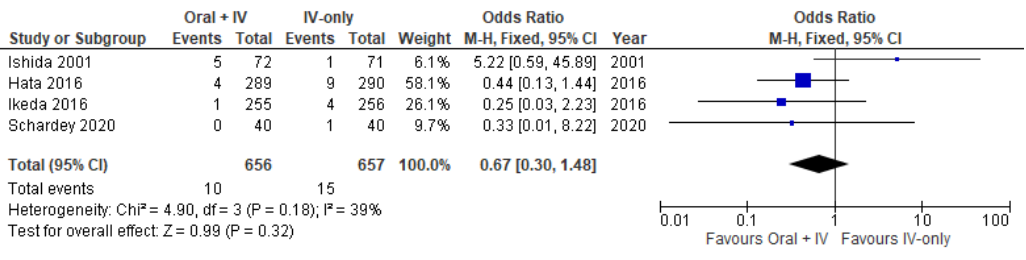
Figure 6. Forest plot of enteritis/colitis comparing oral + IV group and IV-only group.